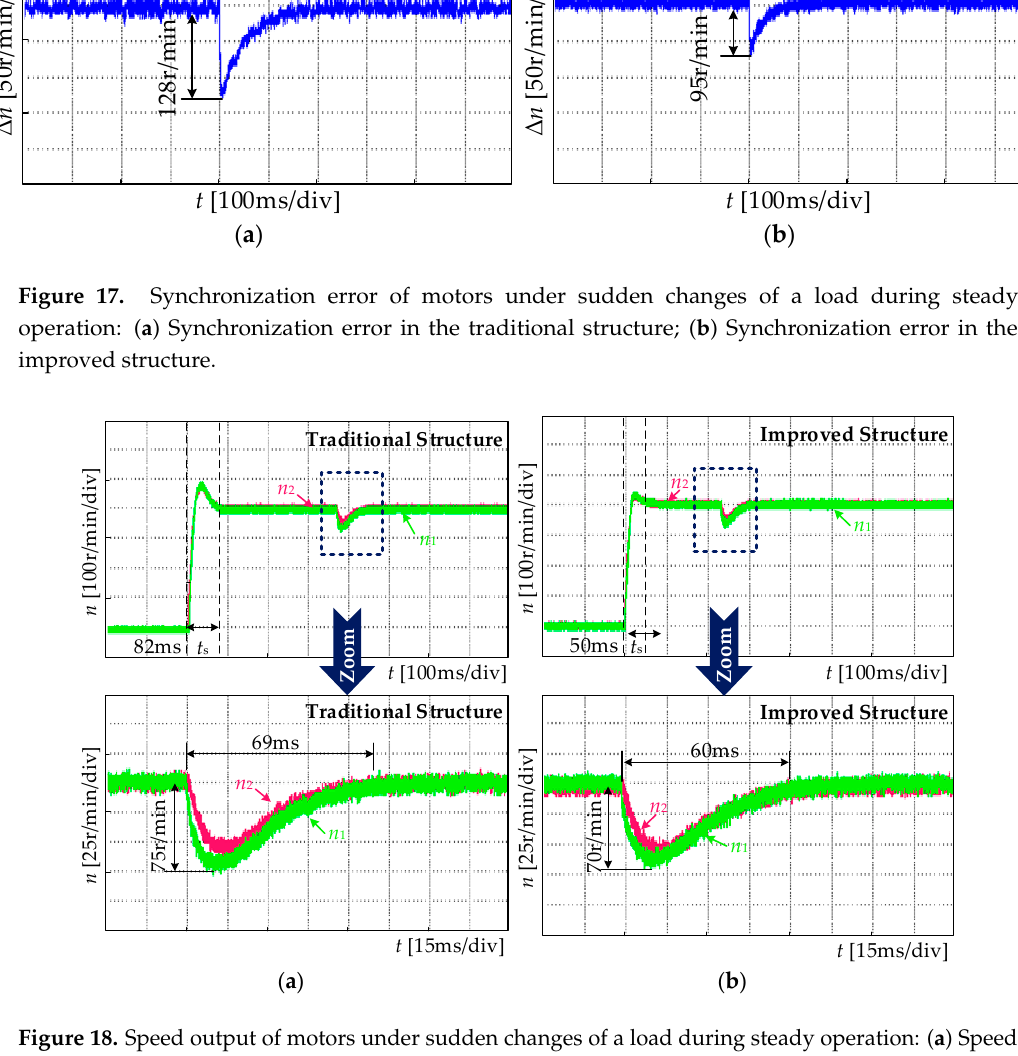
Figure 18. Speed output of motors under sudden changes of a load during steady operation: ( a ) Speed output in the traditional structure; ( b ) Speed output in the improved structure.